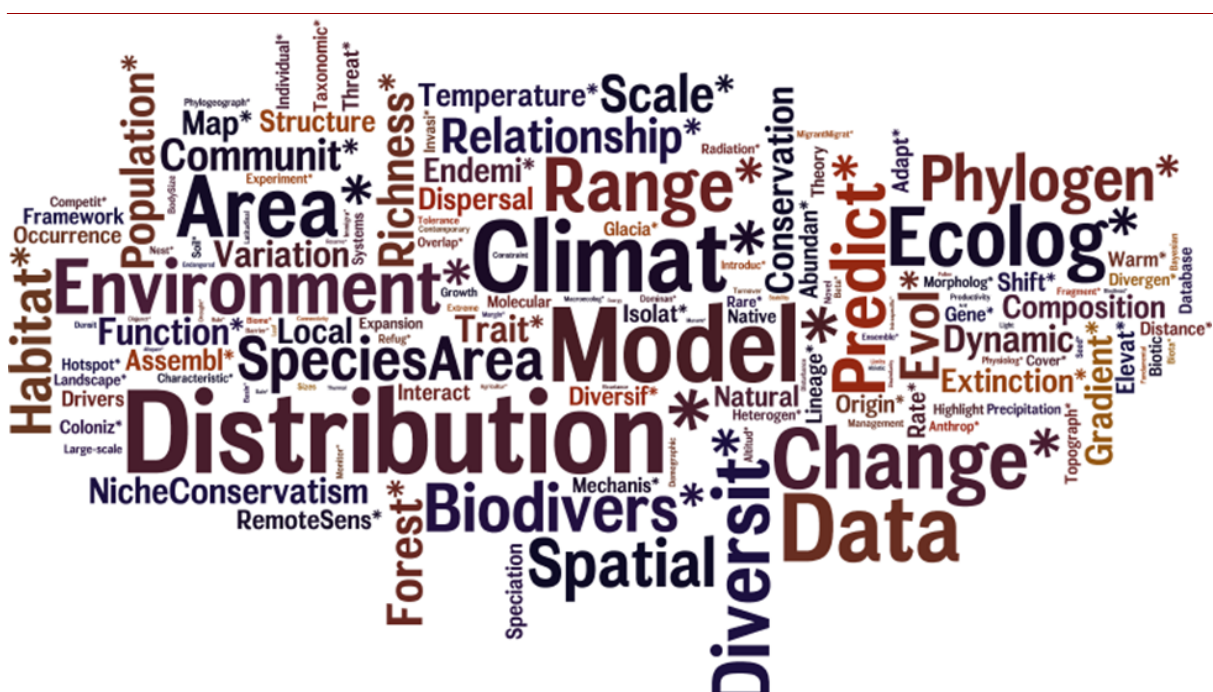
Figure 1. A word cloud composed of biogeography-related topics extracted from 521 abstracts submitted for sympo- sia and contributed oral sessions at the 7 th biennial meeting of the IBS (see Gavin et al. 2014 [G14]). This figure was made using Wordle 3 , after removing terms relating to place (see Figure 2), taxon (see Figure 3), or time (see Figure 4), and all non-biogeographic words such as articles, conjunctions, prepositions, acronyms and most units of meas- urement (see Figure 5), etc. The number of individual words remaining in the analysis, n , totalled 7,565. The word w cloud analysis is used to approximate the frequency of topics at the 7 th IBS meeting while tacitly acknowledging that the semi-qualitative and derived nature of these data can provide only a general guide to the relative frequencies with which topics were addressed. The size of a word is proportional to the number of abstracts in which the word occurred. All abstracts, rather than the subset that were accepted, were used because they arguably provided a less biased representation of the topics that interest the biogeography community. Asterisks indicate root words that appeared in various forms, for example, Biodivers* = biodiverse, biodiversity. Note that diverse topics may be repre- sented in a single high-frequency word such as “Area”, some words may form phrases (e.g., [species] distribution model[ling]). The word “Species” was excluded from this analysis but was present in 451 of the 521 abstracts. The most common term (“Distribution*”) in the analysis occurred in 226 abstracts; the least common term in the analysis occurred in only one